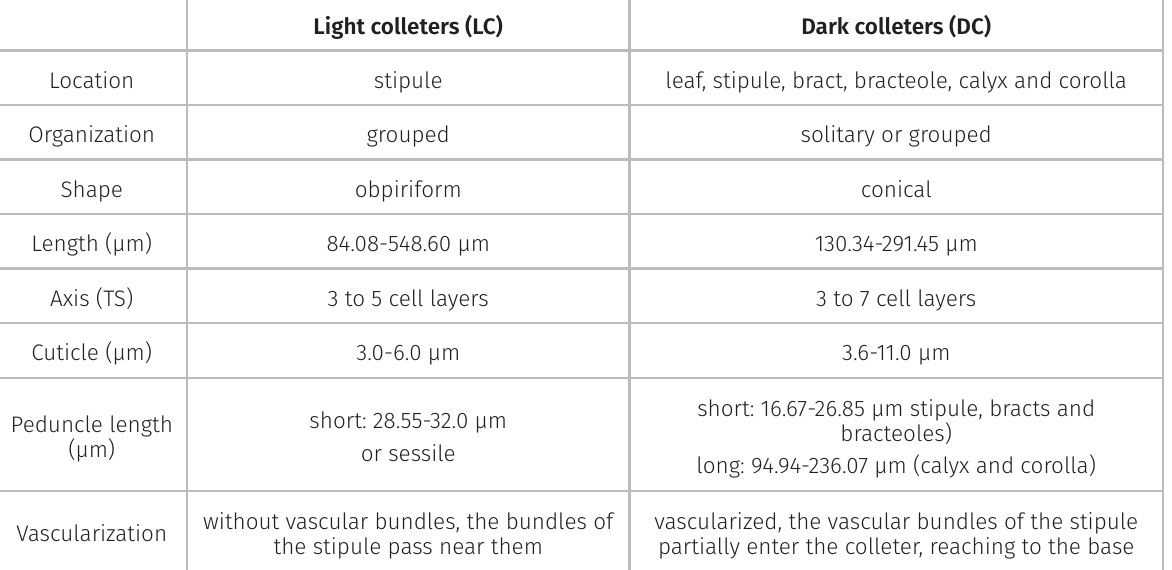
Table I. Morpho-anatomical characteristics of colleters of Cephalanthus